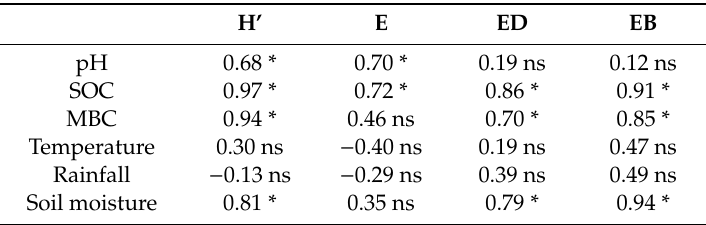
Table 8. Pairwise correlation between earthworm species diversity (H’), evenness (E), density (ED), and biomass (EB) and selected abiotic and biotic parameters across the seasons and experimental factors at the UFH research